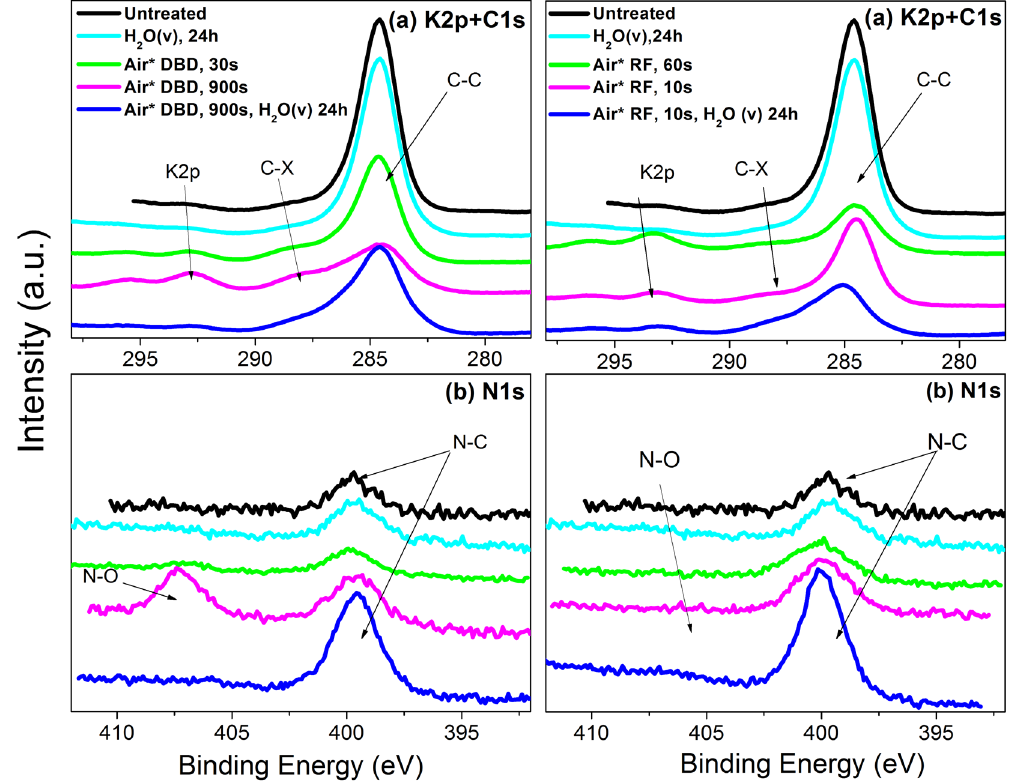
Figure 3. Carbon C1s ( a ) and nitrogen N1s ( b ) high-resolved XPS spectra of Quinoa seeds DBD (left) and RF (right) plasma treated for different treatment times. Curves corresponding to the untreated seeds, the 900 s DBD and the 10 s RF treated seeds after water exposure (24 h) are also